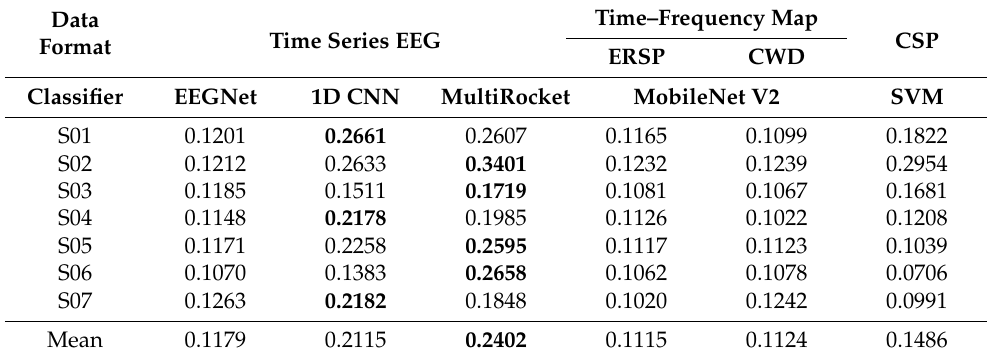
Table 2. Each subject’s classification accuracy of 9-class VP according to the data type and